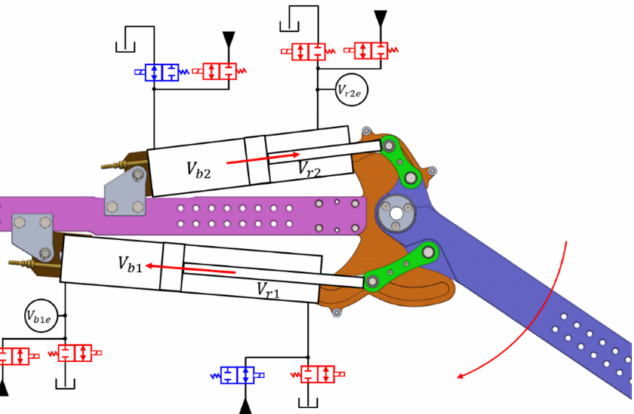
Figure 25. The valve configurations to realize the elastic behavior in the stance phase. To ensure that the pressure in the cylinder chambers remains below their rated pressure (200 bar) in this elastic operation, extra volumes ( V b 1 e and V r 2 e ) are added to the isolated cylinder